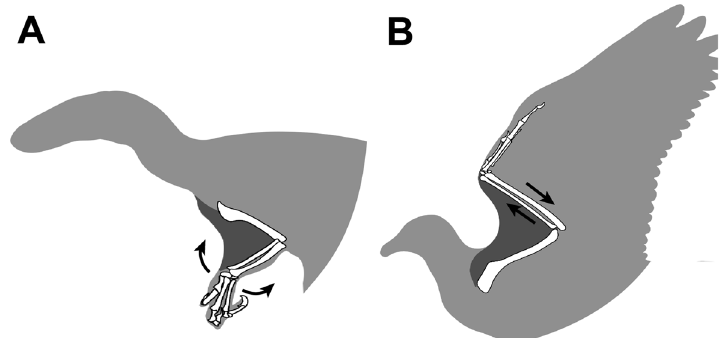
Fig. 5 The “intermediate” and avian-state morphotypes. A Deinonychus antirrhopus representing the “intermediate” morphotype. The propatagium was present, while the wrist could extend toward the radial side in a grasping movement. B Sapeornis chaoyangensis with the avian interlocking wing-folding